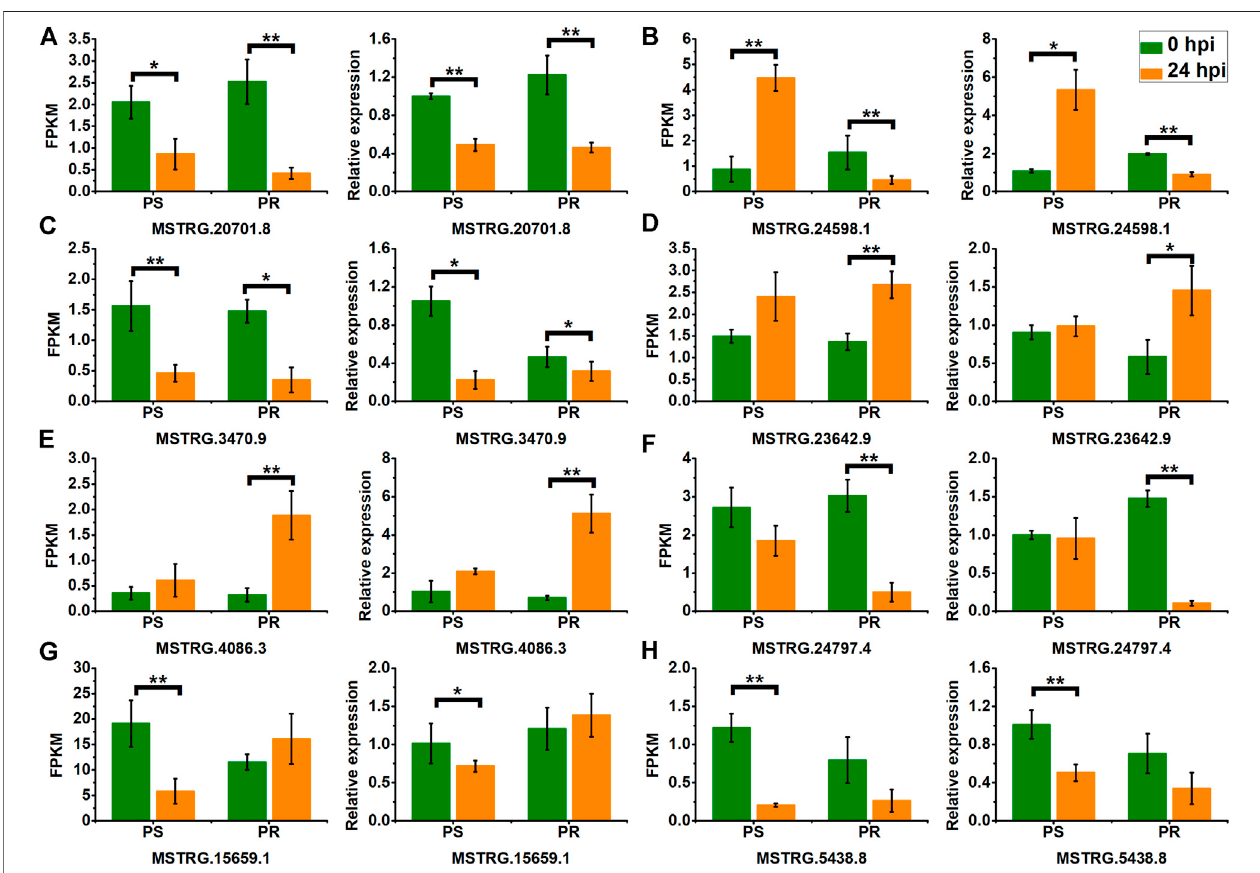
FIGURE 8 | Validation of PM-responsive lncRNAs (A – H) using qRT-PCR. PS represents PM-susceptible C. pepo and PR represents PM-resistant C. pepo . Error bars indicate standard deviations among three biological replicates ( n = 3). Asterisks indicate signi fi cant differences between PS and PR ( “ * ” represents p < 0.05; “ ** ” represents p <